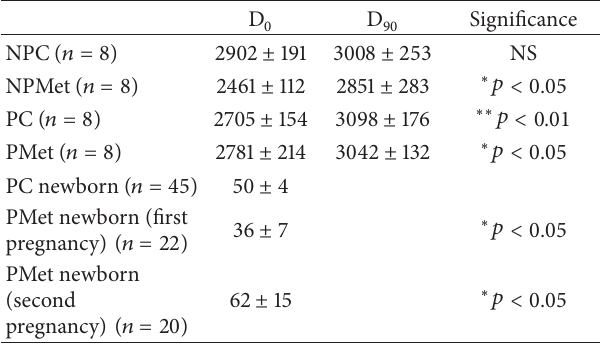
Table 1: Female and newborn body weight (gr). D